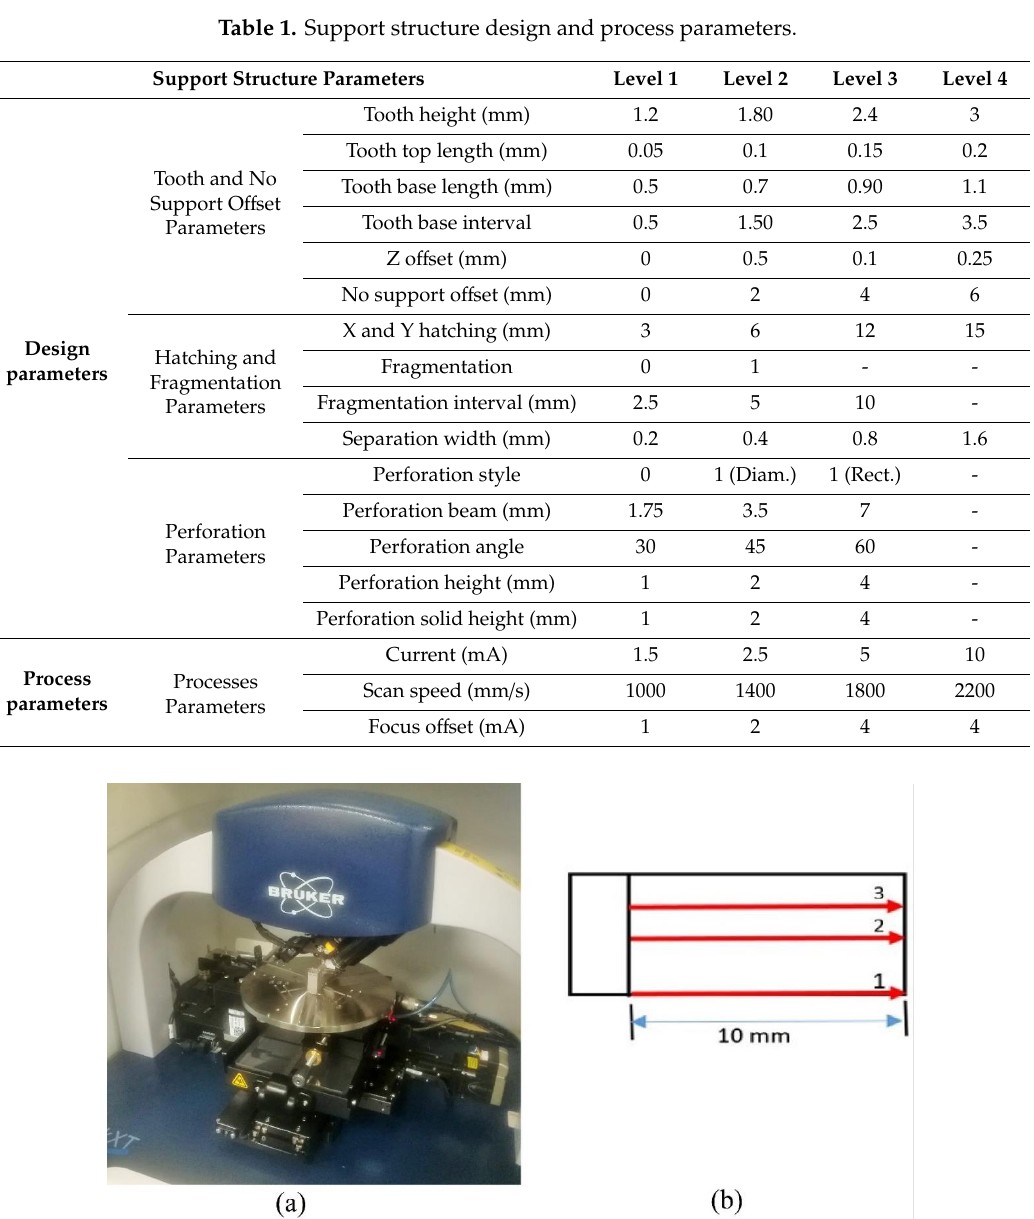
Table 1. Support structure design and process parameters.